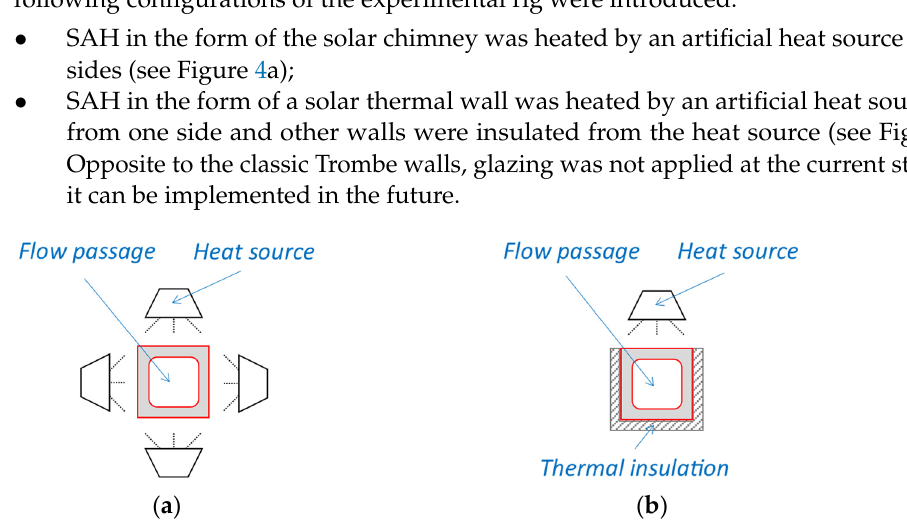
( b ) Figure 3. The experimental rig: the scheme ( a ) and the general view ( b ). The experimental procedure was divided into several steps. Based on the conducted measurements, the following aspects have been analyzed: •